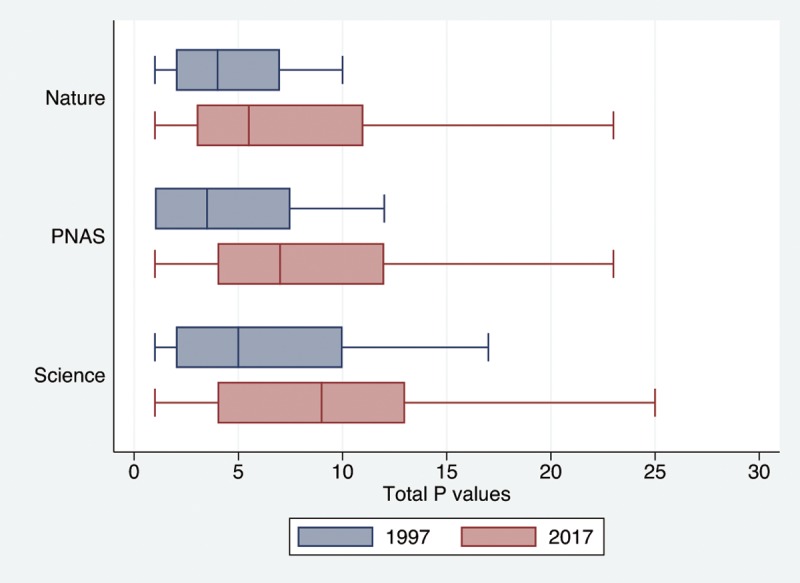
Box plots with standard errors for the total P values by Journal-Year cohorts.Eight outliers (> 30 P values), all from 2017, are not displayed. Median represented by a line on each bar.